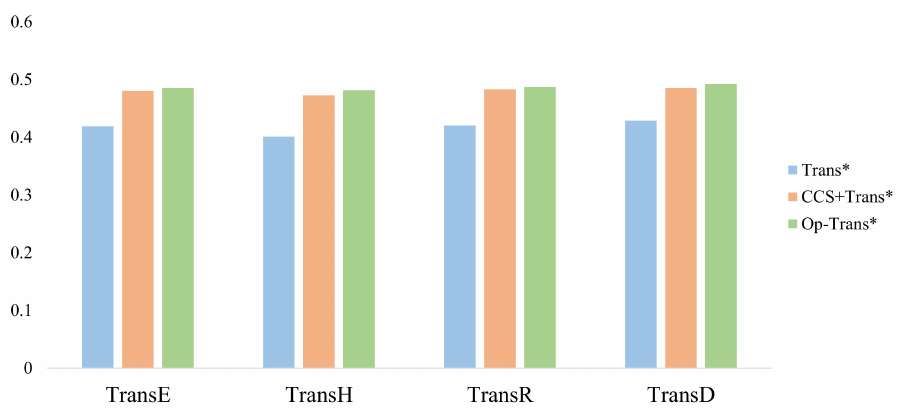
Figure 10. Hits@10 values for the three methods on the dataset FB15K237, ■ indicates initial model, ■ indicates CCS negative sample, ■ indicates Op‑Trans framework, * is denoted as various baseline models.